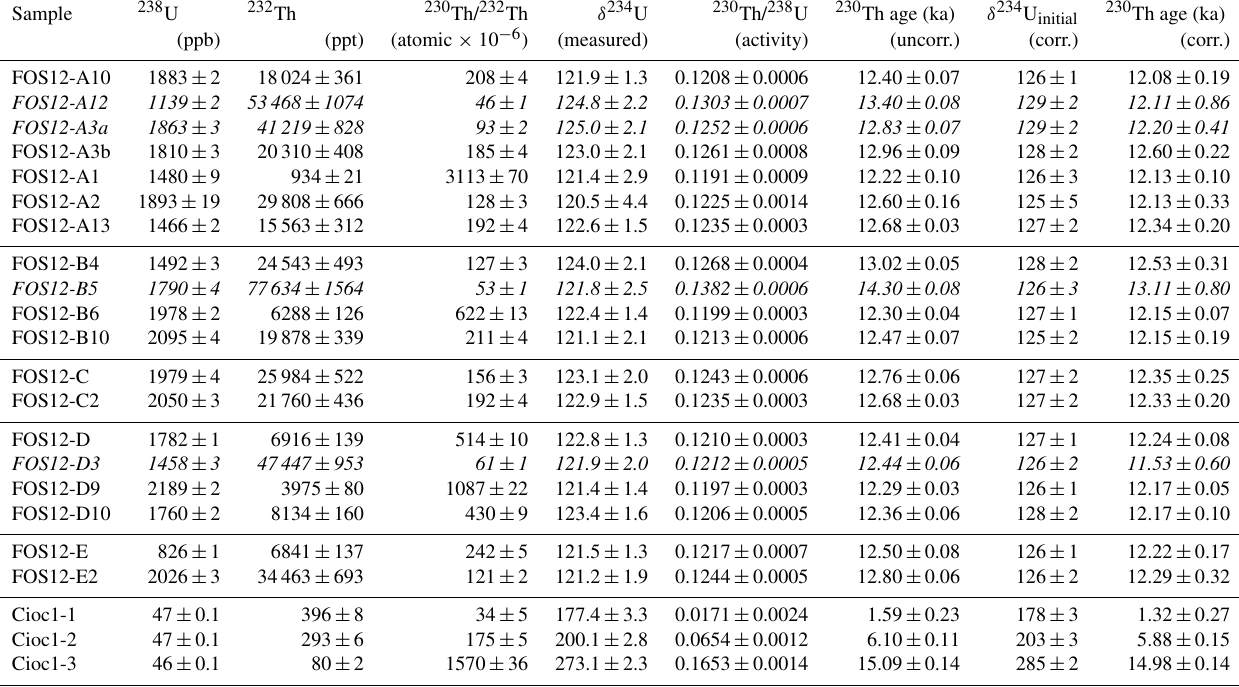
Table 2. 230 Th dating results for cryogenic calcite samples (FOS12) and a stalagmite (Cioc1) from Cioccherloch. Letters in the sample names of CCC (i.e. A, B, C, D, E) indicate the heap where the sample was collected, as shown in Fig. 2. Four samples were excluded from the discussion (italics) because of their excessive 232 Th values. δ 234 U = ([ 234 U / 238 U] activity − 1) × 1000. δ 234 U initial was calculated based on 230 Th age ( t ), i.e. δ 234 U initial = δ 234 U measured × e λ 234 × t . Ages are reported as before present, i.e. before the year CE1950. The error is 2 σ